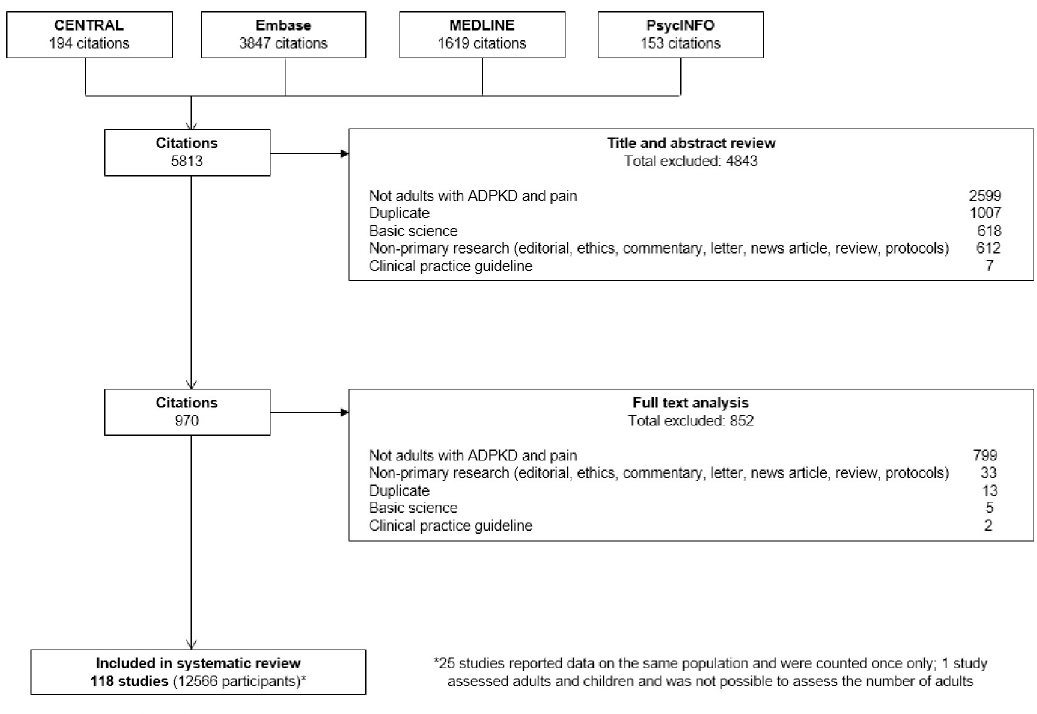
Fig 1. PRISMA flowchart.